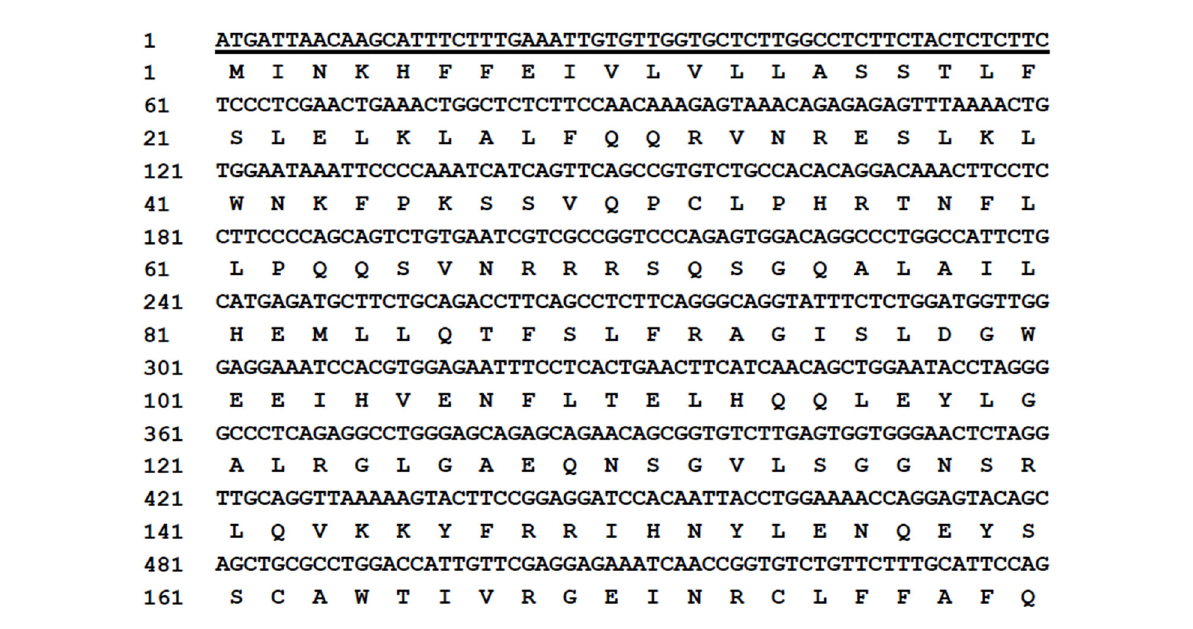
Olympus, Tokyo, Japan) and stained with 0.5% crystal violet for